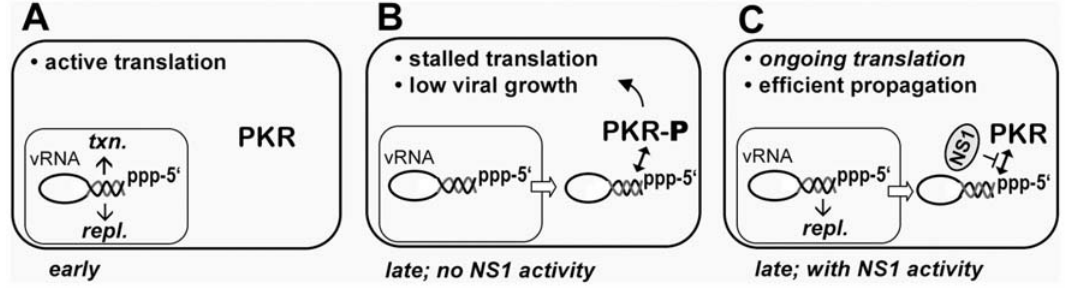
Figure 6. Model for the induction and inhibition of antiviral PKR by influenza virus. The three panels show the localization of the genomic vRNA/RNP complexes with structured 5 9 - and 3 9 -ends together with the phosphorylation status of PKR in early (panel A) and late phases (panels B and C) of virus infection. Viral RNP is located in the nucleus early in infection and is not accessible for cytosolic PKR (panel A). Upon nuclear export at later stages, vRNP complexes stimulate PKR activation in the absence of functional NS1 protein, leading to an inhibition of viral proteins synthesis and replication (panel B). However, the presence of functional viral NS1 protein suppresses this antiviral reaction thereby supporting high-level viral propagation (panel